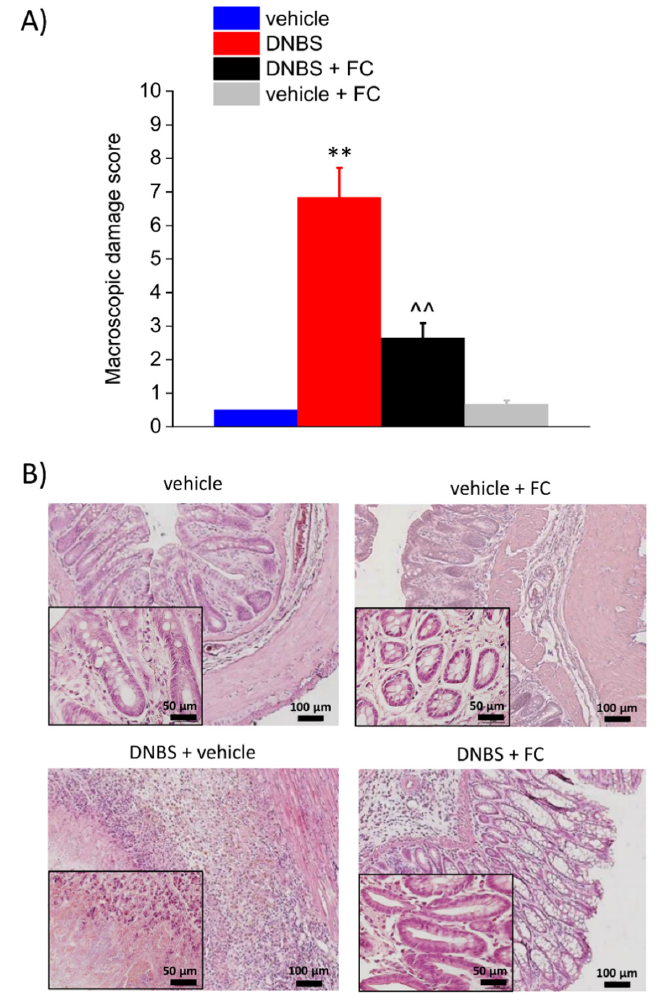
Figure 2. Effect of systemic fluorocitrate administration on colon damage induced by DNBS. ( A ) Colon macroscopic damage score. ( B ) Representative pictures of haematoxylin–eosin ‐ stained sec ‐ tions of full ‐ thickness colon. Original magnification: 10× and 40×. Each value represents the mean ± SEM of 8 animals per group. ** p < 0.01 vs. vehicle. ^^ p < 0.01 vs. DNBS. Original magnification: 10× and 40×. Scale bars: 50 and 100 μ m.